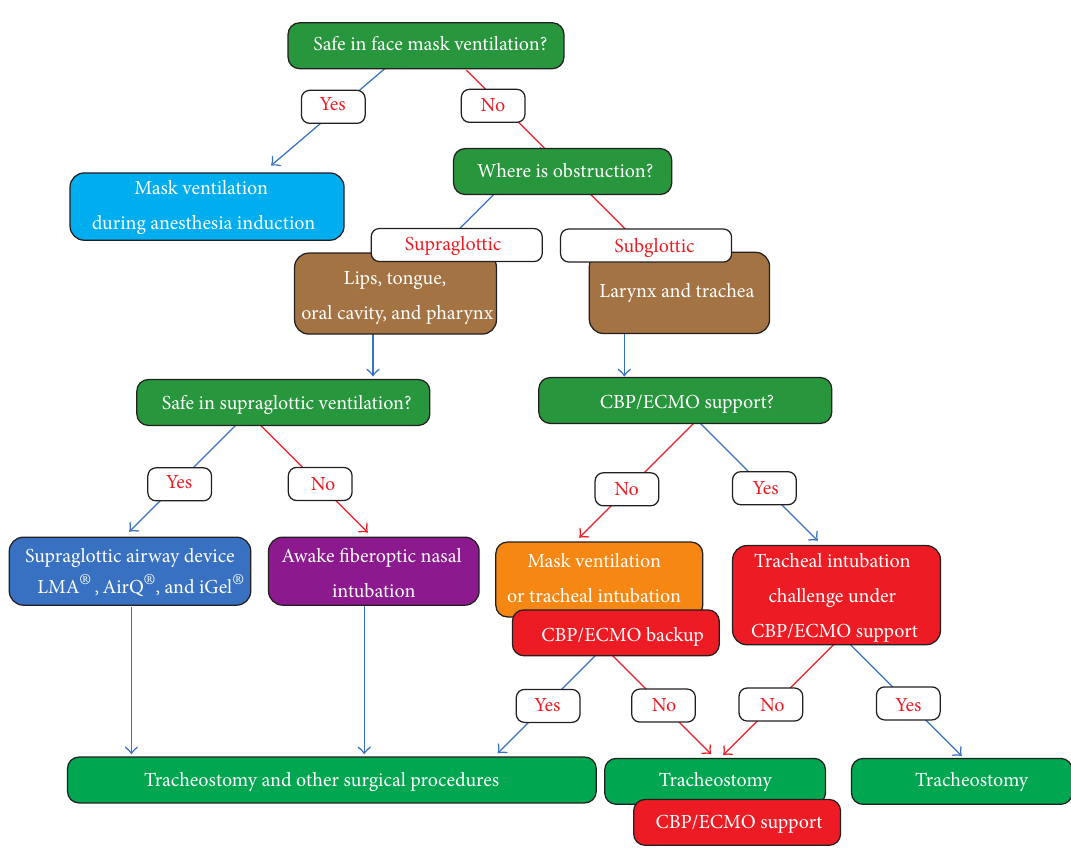
Figure 3: Algorithm for anticipated difficult airway management for infants. Supraglottic airway devices and awake nasal fiberoptic intubation, as well as extracorporeal cardiopulmonary support or extracorporeal cardiopulmonary backup support, are incorporated into the